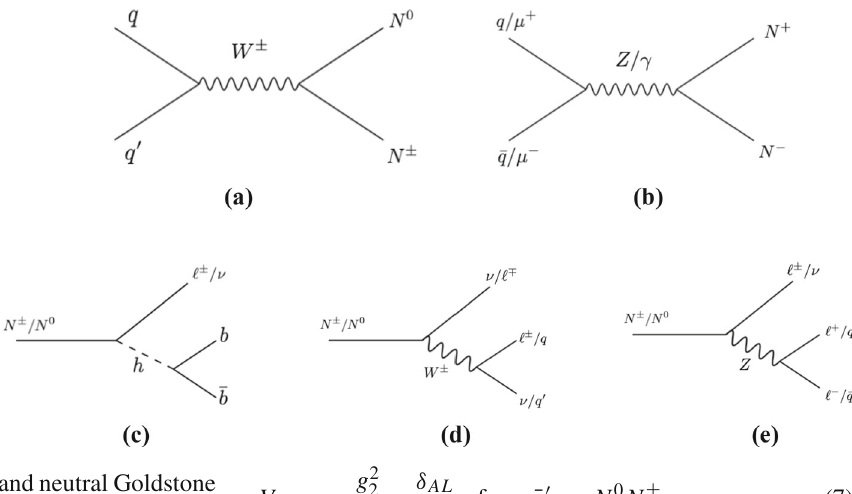
Fig. 1 Feynman diagrams of the production and decay of Type-III fermions N 0 and N ± . a Shows the associate production at the LHC/FCC and b depicts the pair production of N ± at the LHC/FCC and the muon collider. The decay of N 0 and N ± to Higgs boson and SM gauge bosons are shown in c , d and e